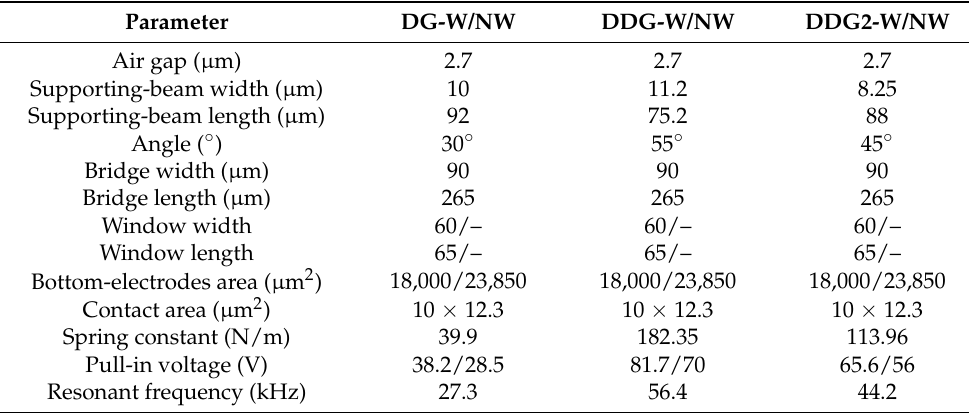
Table 1. Dimensions and numerical mechanical parameters.